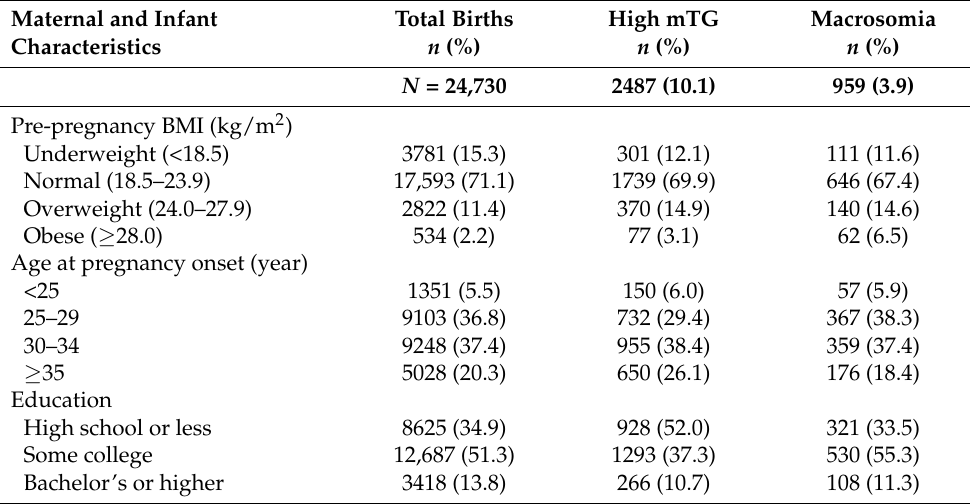
Table 1. Distribution of maternal and infant characteristics in the study sample of singleton births ( N = 24,730), according to high mTG and macrosomia births.